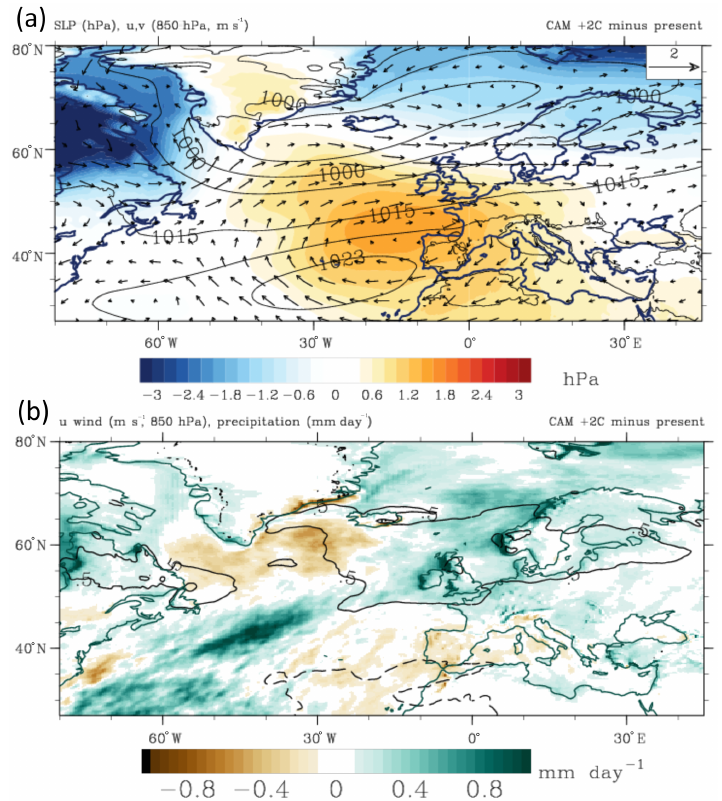
Figure 4. Difference between + 2 ◦ C (runs 2106–2115) and present climate ensemble means (2006–2015) in DJF (a) sea level pressure (shaded, hPa) and wind vector at 850hPa (ms − 1 ). Contours show DJF sea level pressure in present climate ensemble, with a local maximum in the vicinity of the Azores and minimum in the vicinity of Iceland; (b) precipitation (mmday − 1 ) and zonal wind (contours, ms − 1 ) in